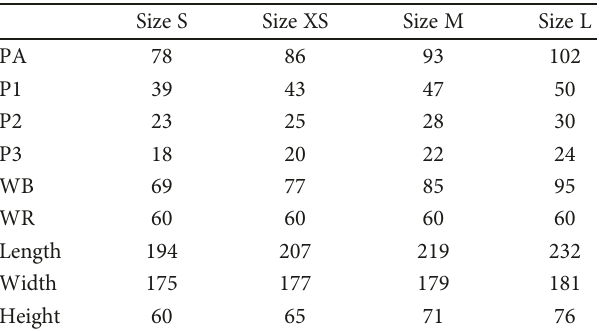
Figure 9: Support version V3: design, fabrication, and use. Table 2: Considered values (in mm) for each size.